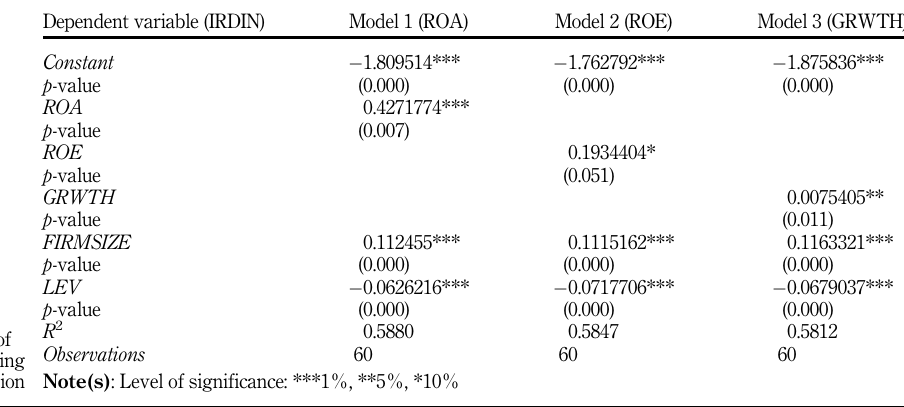
Table 5. Regression output of model 1, 2 and 3 using OLS robust